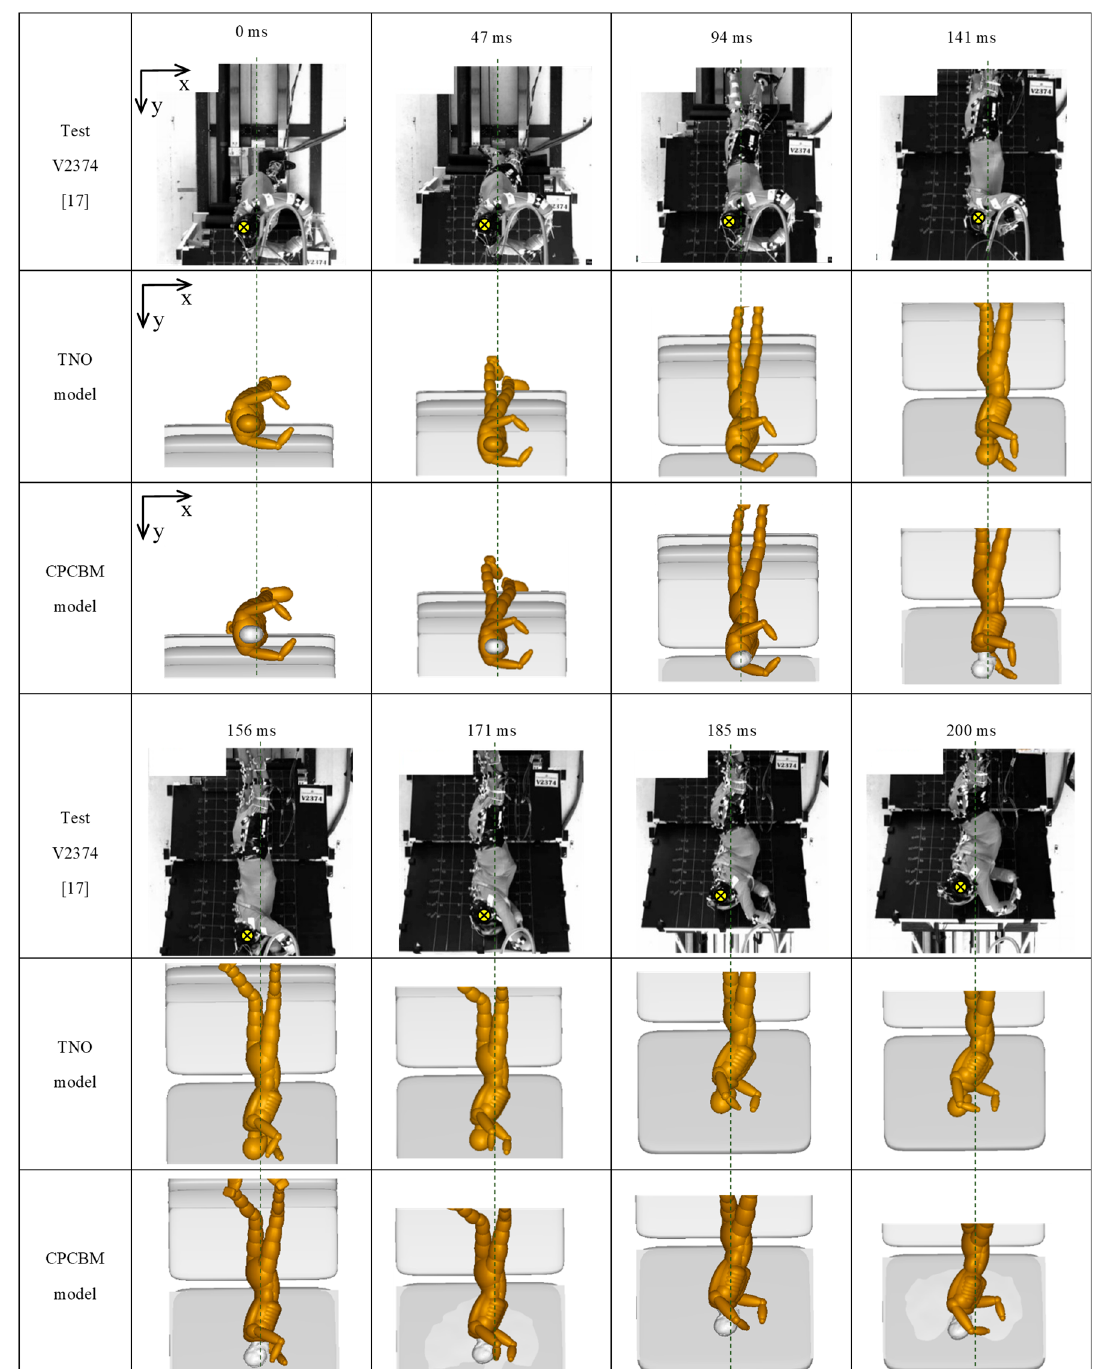
Figure A6. Motion responses of PMHS, the TNO model (gold color), and CPCBM (mixed color) for test V2374 (superior view) [17].